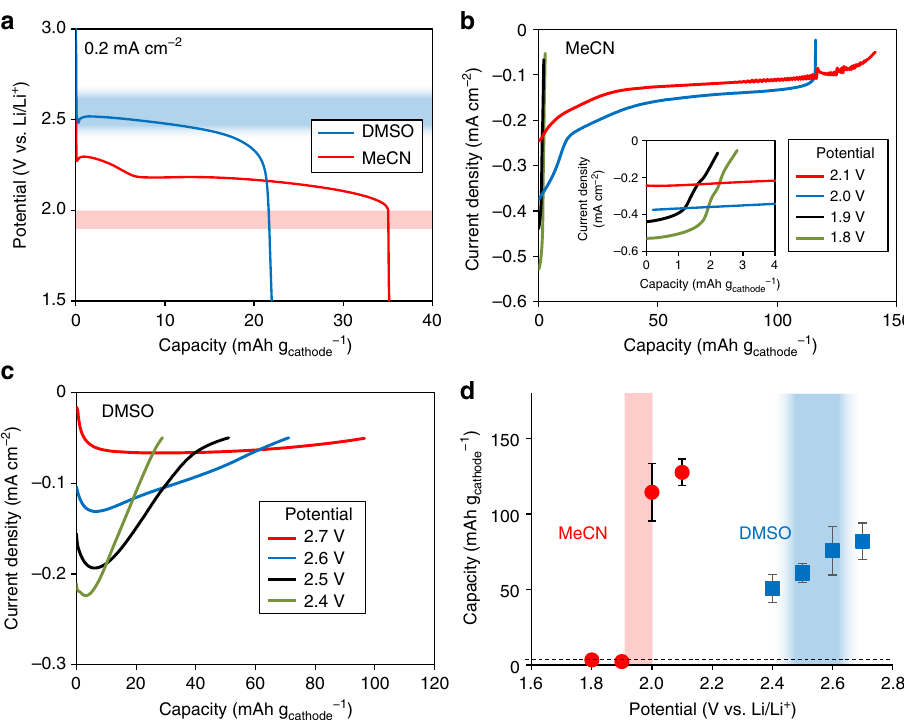
Fig. 5 Estimation of NDR potential region. a Galvanostatic discharge curves obtained in 0.05M LiTFSI electrolytes. The applied current densities were 0.2 mAcm − 2 . b , c Potentilstatic discharge curves obtained in 0.05 M LiTFSI electrolytes with pre-discharging. The cut off current density was 0.05mAcm − 2 . b The inset shows the magni fi ed image of b . d Discharge capacities of potentiostatic discharging at various potentials corresponding to Fig. 5b (MeCN, red circles) and 5c (DMSO, blue squares). The horizontal dashed line shows the capacity supposed to be obtained with surface pathway (3.6 mAh g cathode − 1